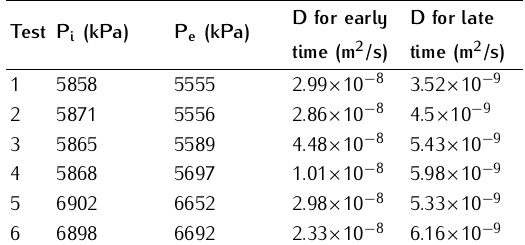
Table 7. Diffusion coefficients at initial and final (equilibrium).